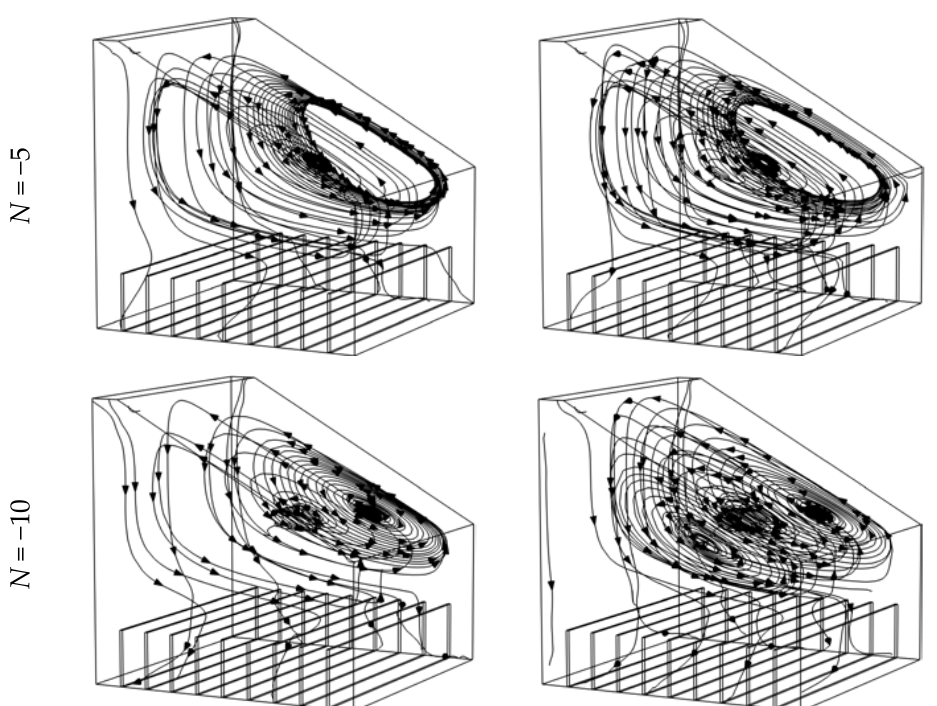
Figure 5. Effect of the buoyancy and conductivity ratios on the 3D flow structure for Ra = 10 5 . Rc = 0.01 Rc = 100